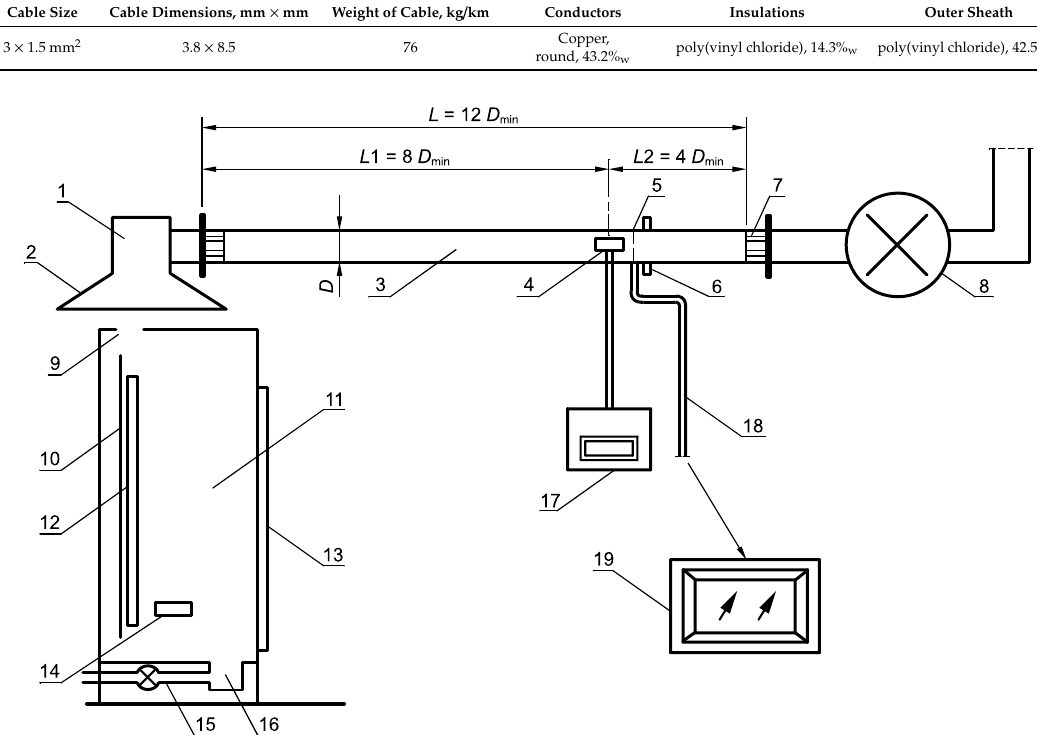
Figure 8. Schematic of test equipment in accordance with the EN 50,399 standard [28]; 1—chamber,